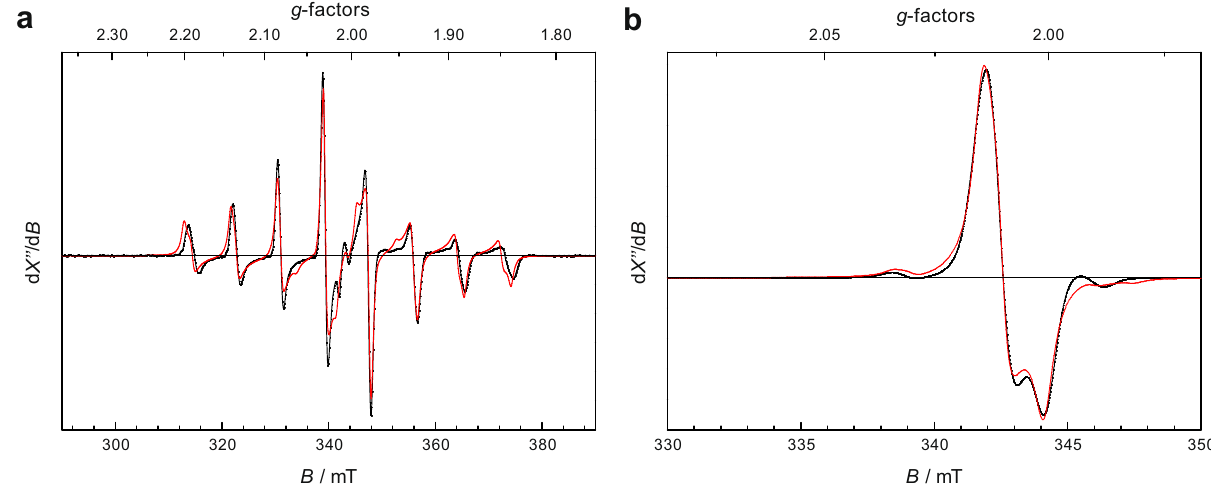
Fig. 2 X-band EPR spectra of complexes 2 and 3 (black trace) and simulation (red trace). a Spectrum of 2 recorded at 30 K. b Spectrum of 3 recorded at 40 K.